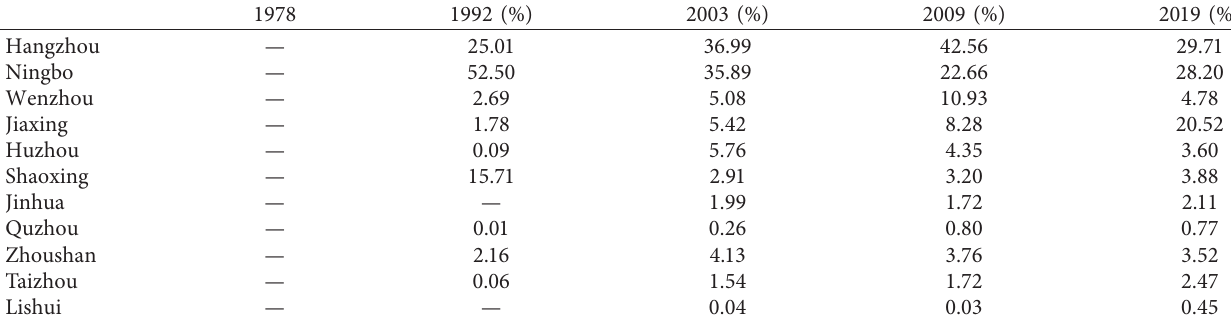
Table 6: Proportion of enterprise investment in cities in Zhejiang Province.